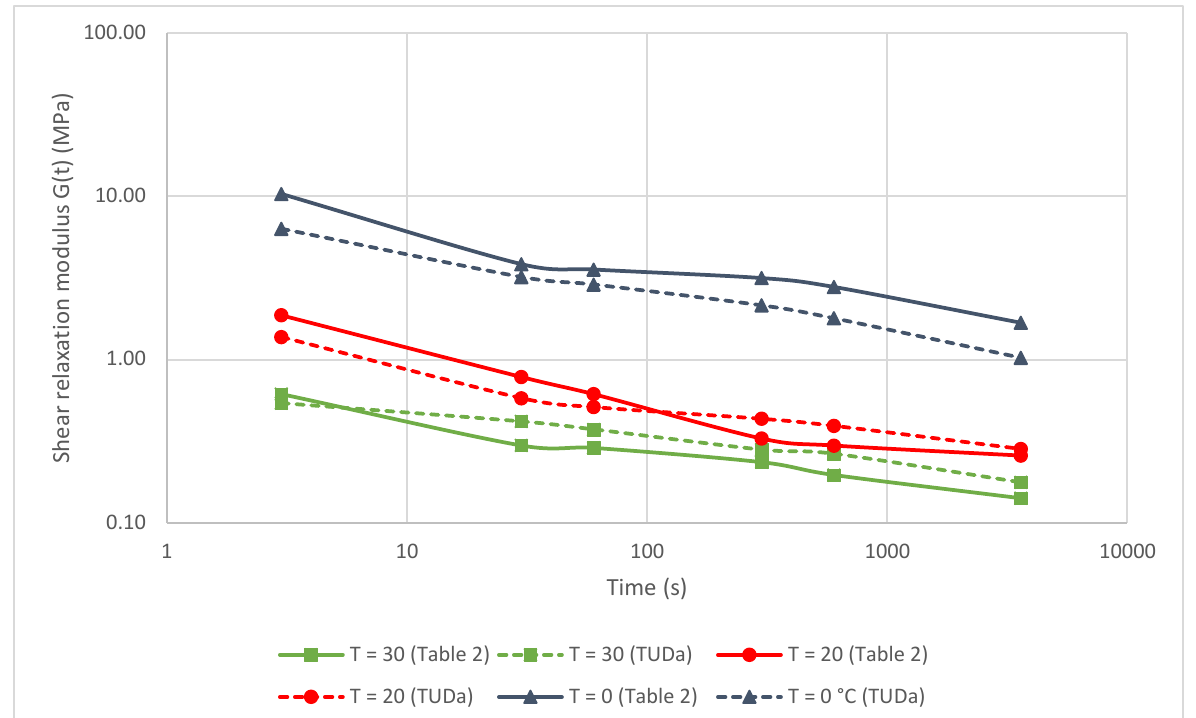
Fig. 5 Shear relaxation modulus for acoustic PVB for durations between 3s and 1 hour at different temperatures for the model of Table 2 (solid lines) and independent model (dotted lines, Schuster and Schneider 2019). To validate the rheological model of Table 2, additional four-point bending experiments on laminated glass specimens of 360 *1100 mm were executed over this temperature range (detail see previous section). A comparison of the modulus values derived from these measurements is given in Figure 6. Bearing in mind the specific nature of the trilayer acoustic PVB’s, the very different scales of these experiments, and the significant amount of data processing that is required in both methods for the data generation of Figure 4, the results are in a remarkably narrow range. The model of table 2 is conservative relative to the four-point bending data at temperatures exceeding 20 °C.